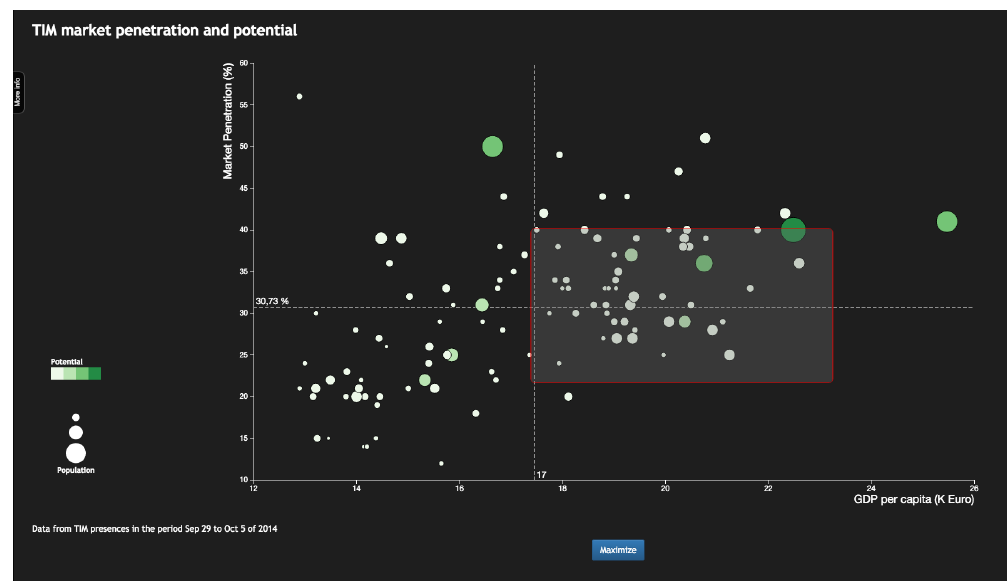
Figure 3. The scatterplot allows selecting a group of provinces that capture some high level campaign scenarios. In the shown example, the analyst has selected provinces characterized by high income and a market penetration close to the median. The objective is to promote some additional non-essential features (e.g., faster network services or more data volume) that will likely be accepted by existing TIM customers, but that also have a chance to win over new customers. As the potential customers need to be able to pay for these additional features, the analyst purposefully chose high income provinces as a suitable subset from which to extract the Top-10 provinces.